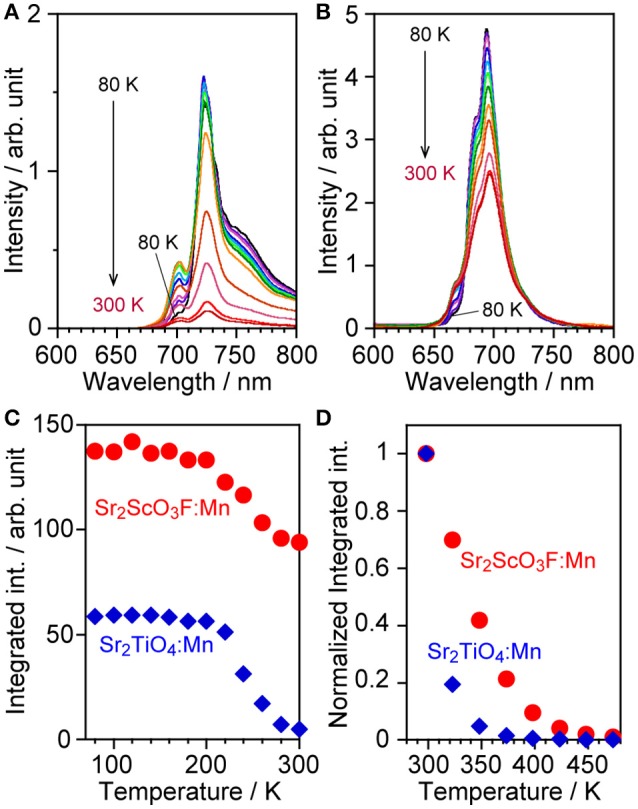
Emission spectra of (A) Sr2TiO4:Mn and (B) Sr2ScO3F:Mn at low temperature (80–300 K), (C) relative integrated emission intensity of them, and (D) normalized integrated emission intensity of Sr2TiO4:Mn and Sr2ScO3F:Mn at high temperature (298–473 K). Excitation wavelengths were 380 and 340–345 nm for Sr2TiO4:Mn and Sr2ScO3F:Mn, respectively.